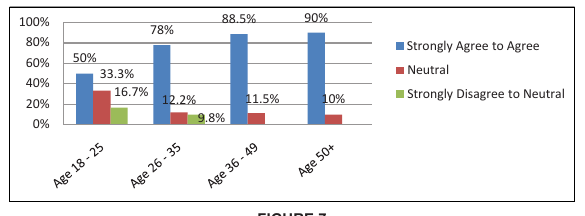
Internet banking done due to bank's financial & Information Technology capabilities - per